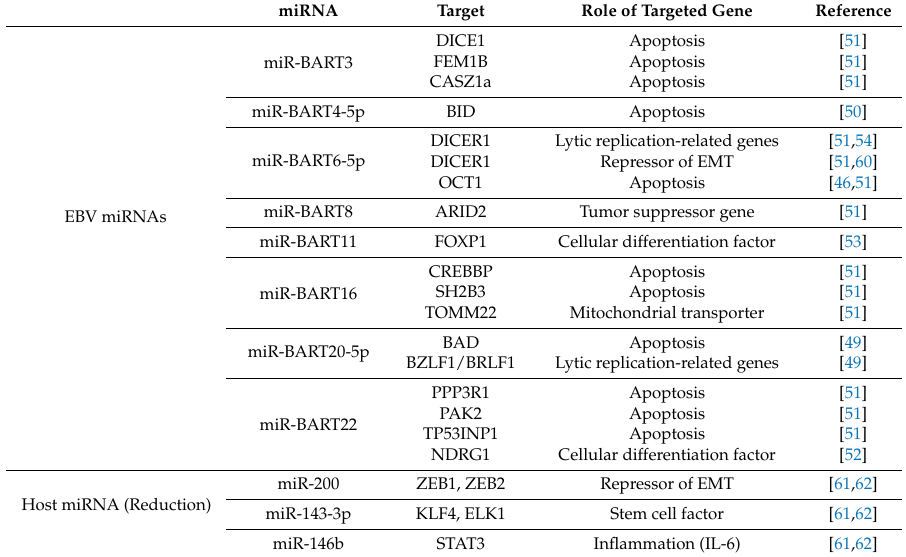
Table 2. The role of miRNAs in EBVaGC.